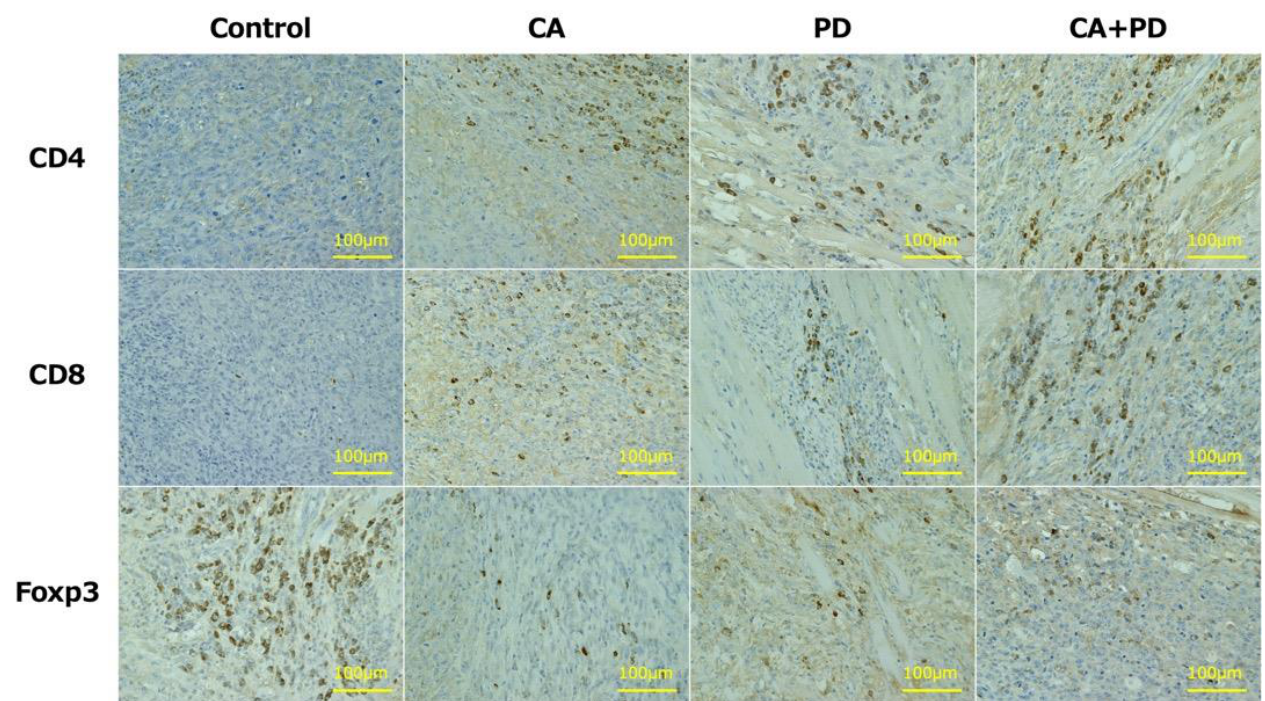
Figure 5. Number of immune-related cells infiltrating the abscopal tumor observed under HPF in the four groups (* p < 0.05, ** p < 0.01). ( a ) Number of CD4 + T cells in the four groups. ( b ) Number of CD8 + T cells in the four groups. ( c ) Number of Foxp3 + T cells in the four groups.